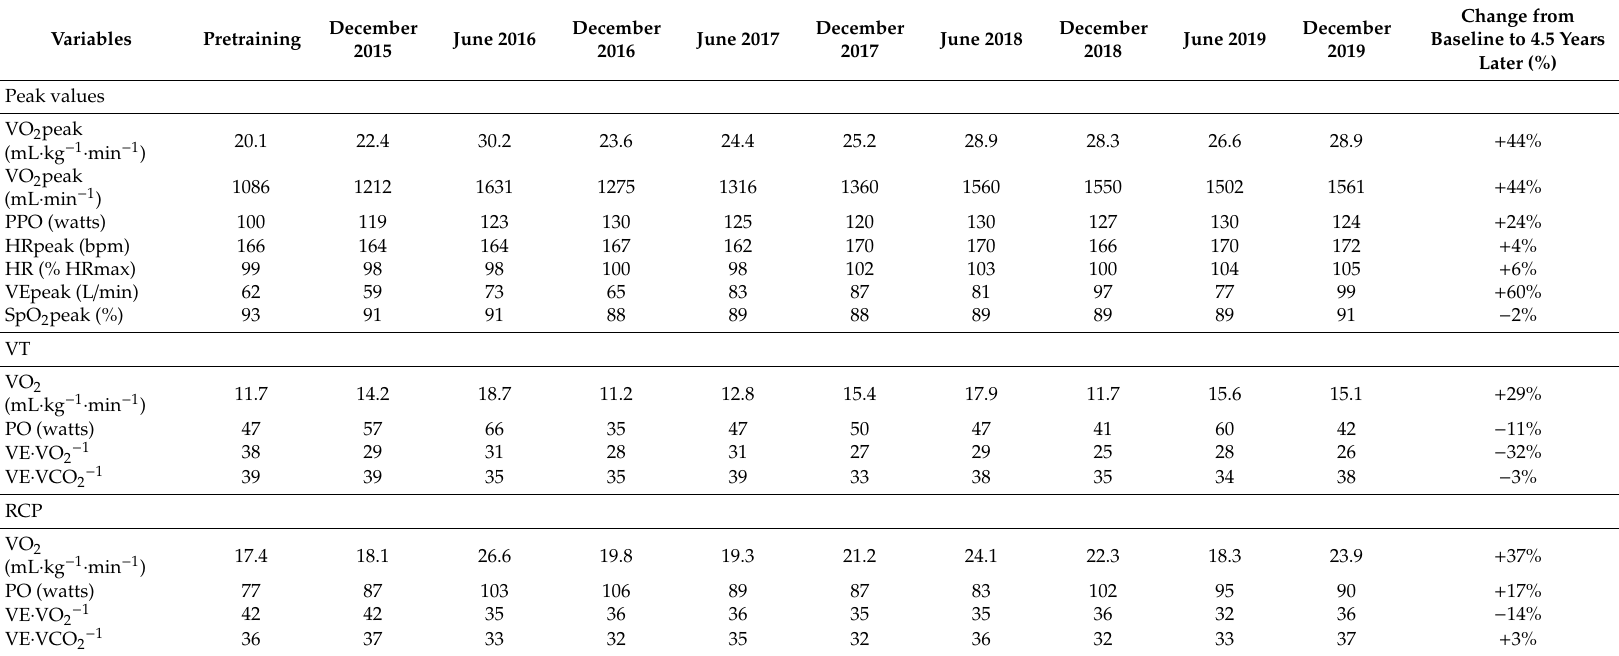
Table 3. Results of cardiopulmonary exercise